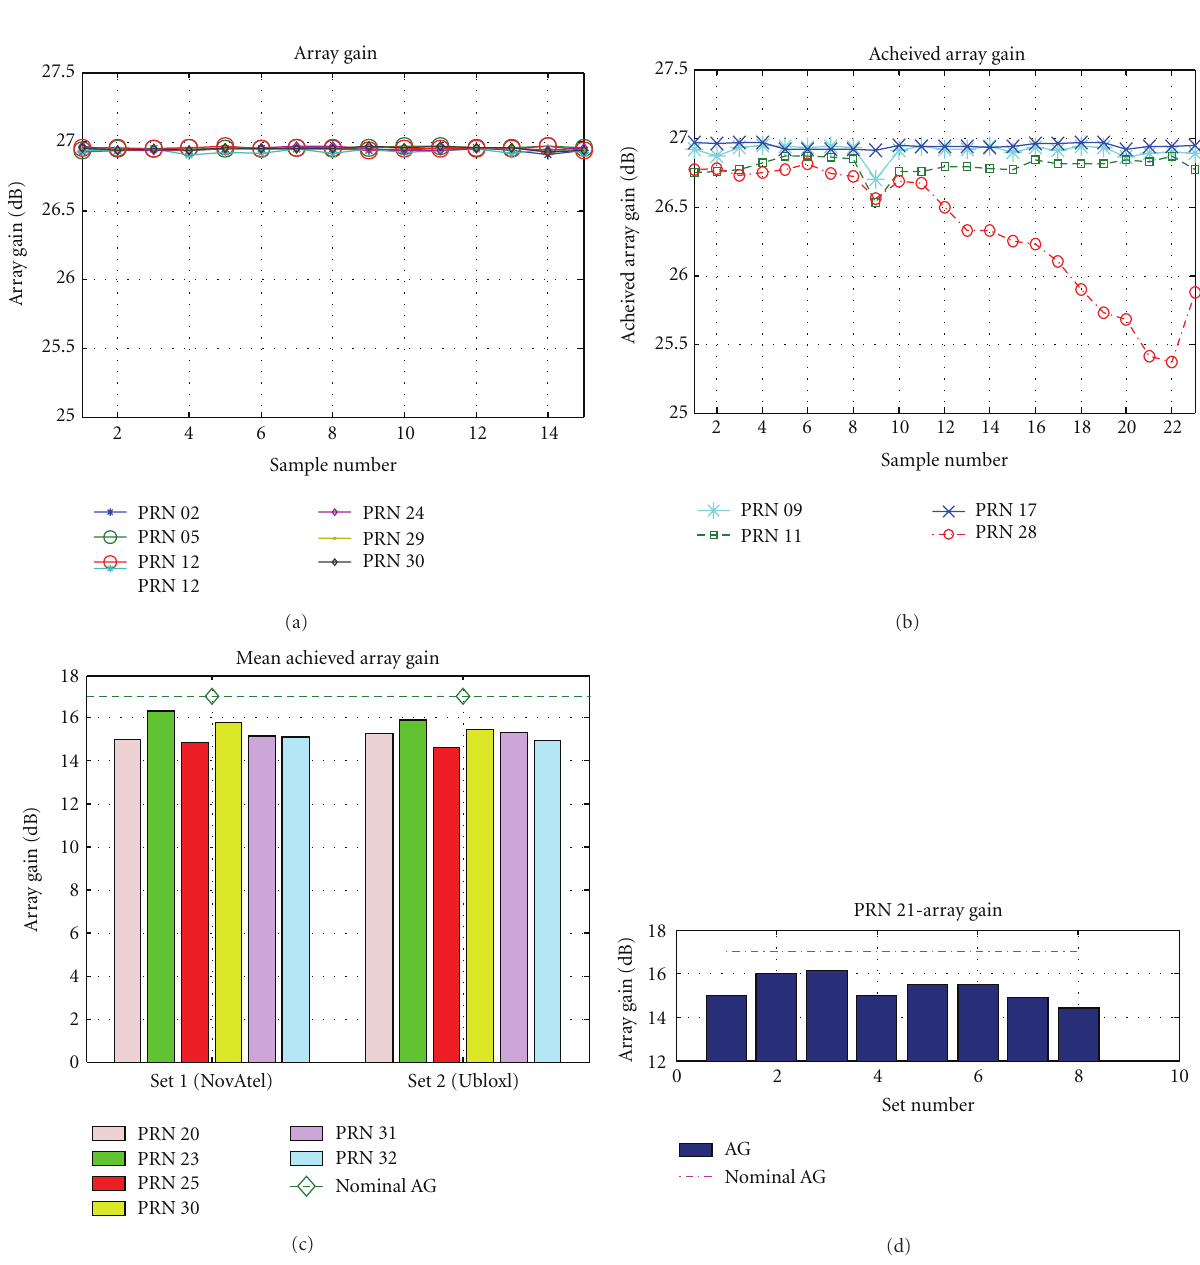
Figure 11: Achieved array gain for di ff erent environments, (a) set by set, di ff erent PRNs, roof top, (b) set by set, di ff erent PRNs, urban canyon, (c) mean array gain, di ff erent PRNs and data sets, in residential house, and (d) mean array gain for PRN 21 in di ff erent data sets,